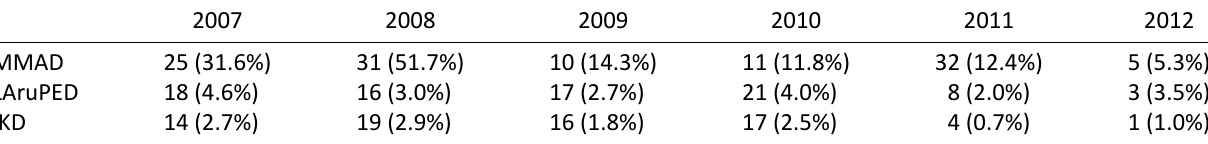
Table 3. Protest events in North Caucasus by data source and